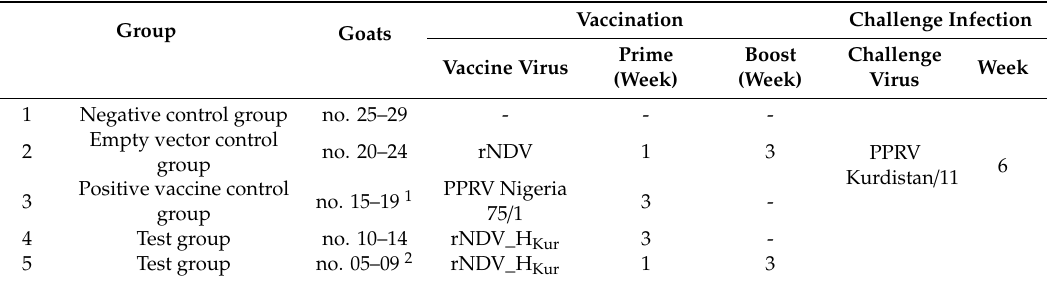
Table 1. Experimental design of the animal